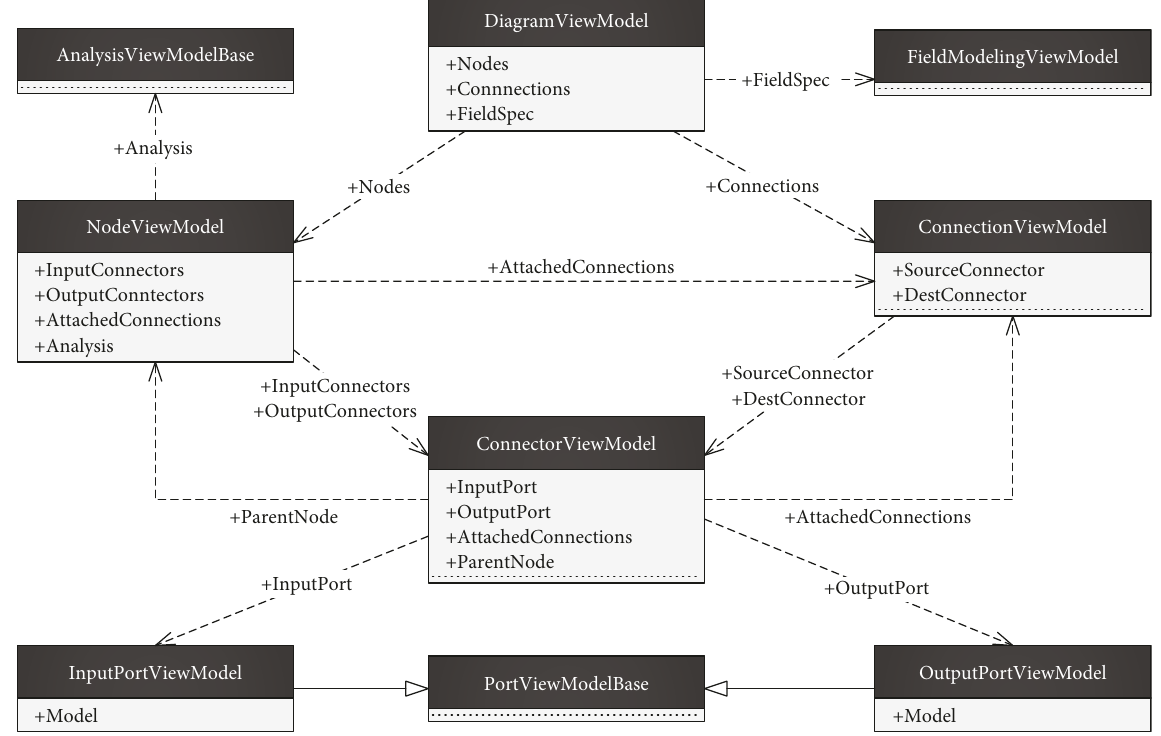
Figure 6: Class diagram for logic modeling using network con fi